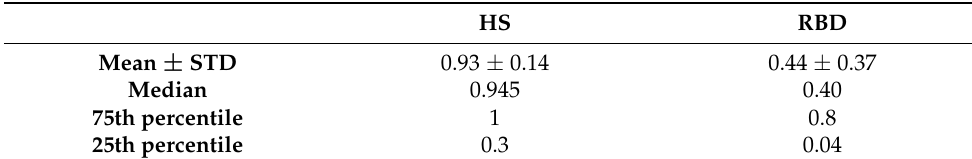
Table 3. REM Sleep Atonia Index (RAI) statistical parameters computed for healthy subjects (HS) and RBD. Subjects 5–7 (HS) are not included.